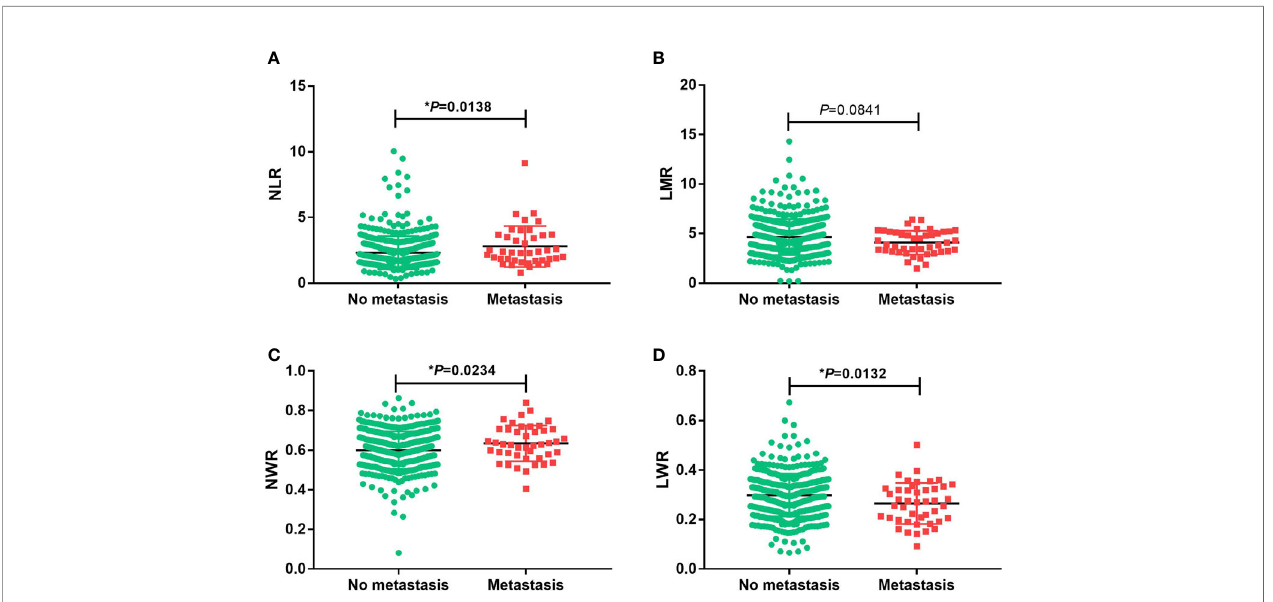
FIGURE 1 | Associationsof the prognosticvalues with the state of metastasisin oral squamouscellcarcinoma. (A) neutrophil-to-lymphocyte ratio(NLR), (B) lymphocyte- to-monocyte ratio (LMR), (C) neutrophil-to-white blood cell ratio (NWR) and (D) lymphocyte-to-white bloodcellratio(LWR). Asterisks(*) indicate statistical signi fi